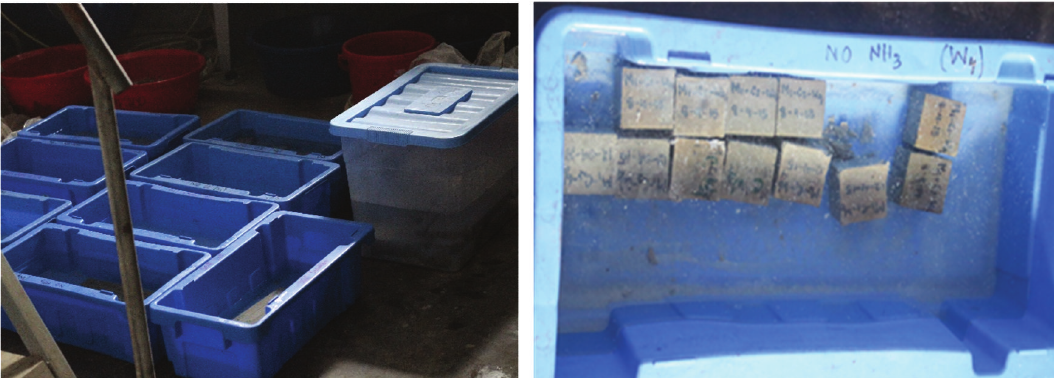
Figure 1: Specimens submerged in different types of water.